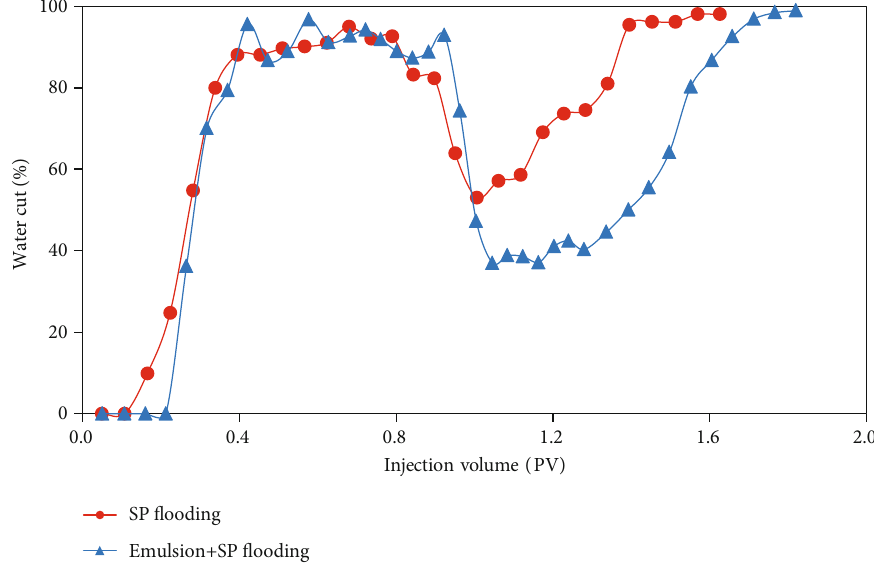
Figure 5: Water cut curves of SP fl ooding and emulsion fl ooding following SP fl ooding. Table 3: Oil recoveries of di ff erent displacement stage in dual-core